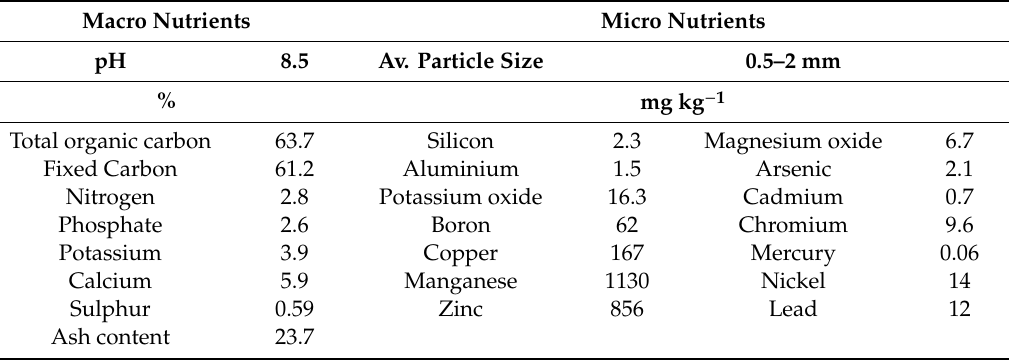
Table 3. Selected chemical properties of Black Earth chicken litter